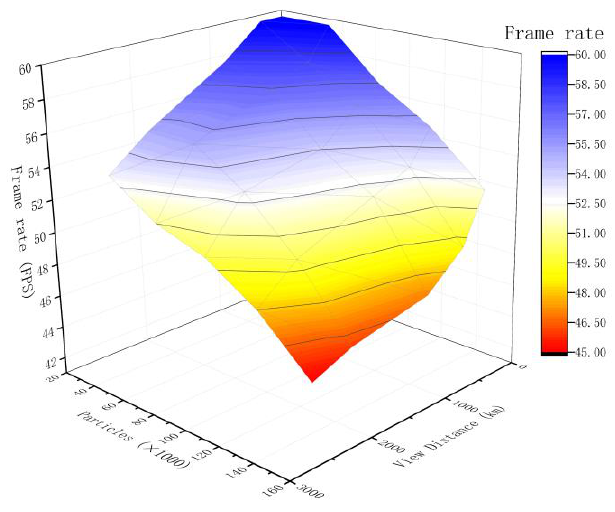
Figure 14. Statistics of rendering efficiency at different viewing angles based on frame rate.